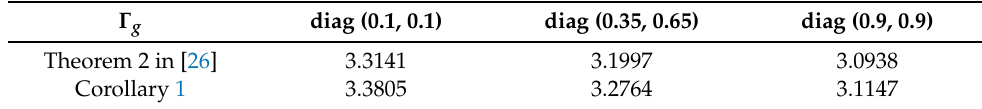
Table 1. Optimal performance β for different Γ g and n ˜ x = 1.